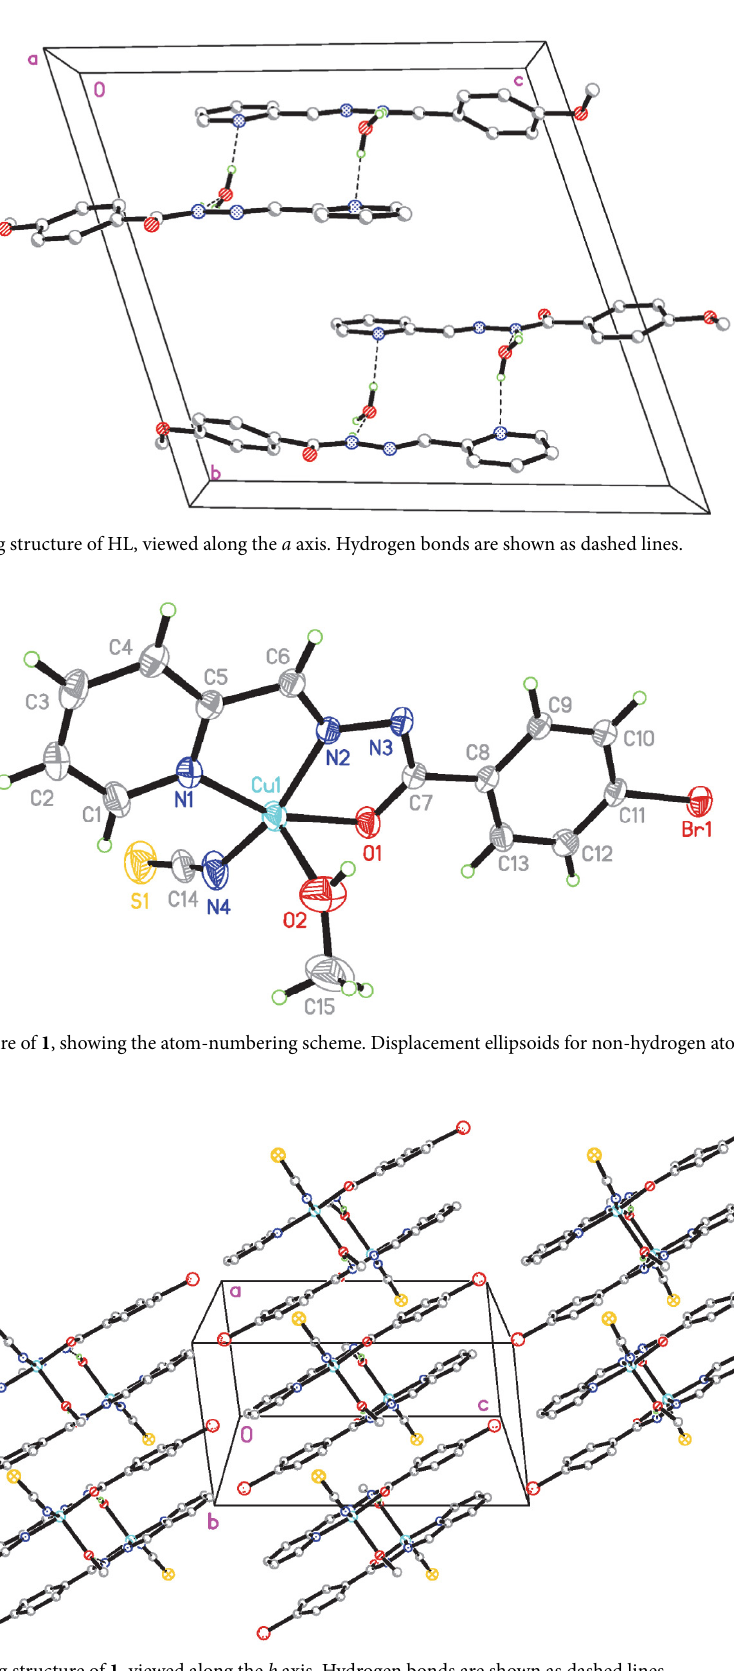
Wang et al.: Synthesis, Characterization, Crystal Structures ...